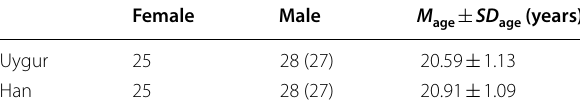
Table 3 Participants demographics and